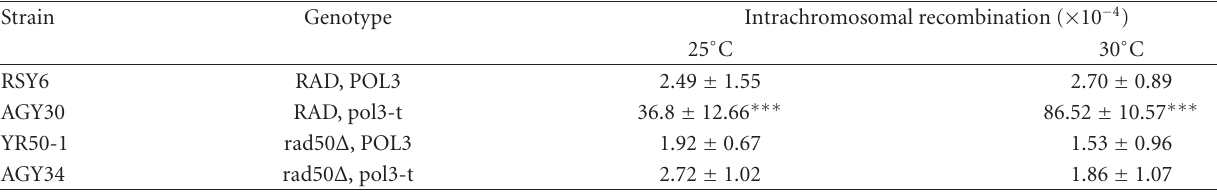
Table 2: E ff ect of RAD50 on the hyperrecombination phenotype of pol3-t .